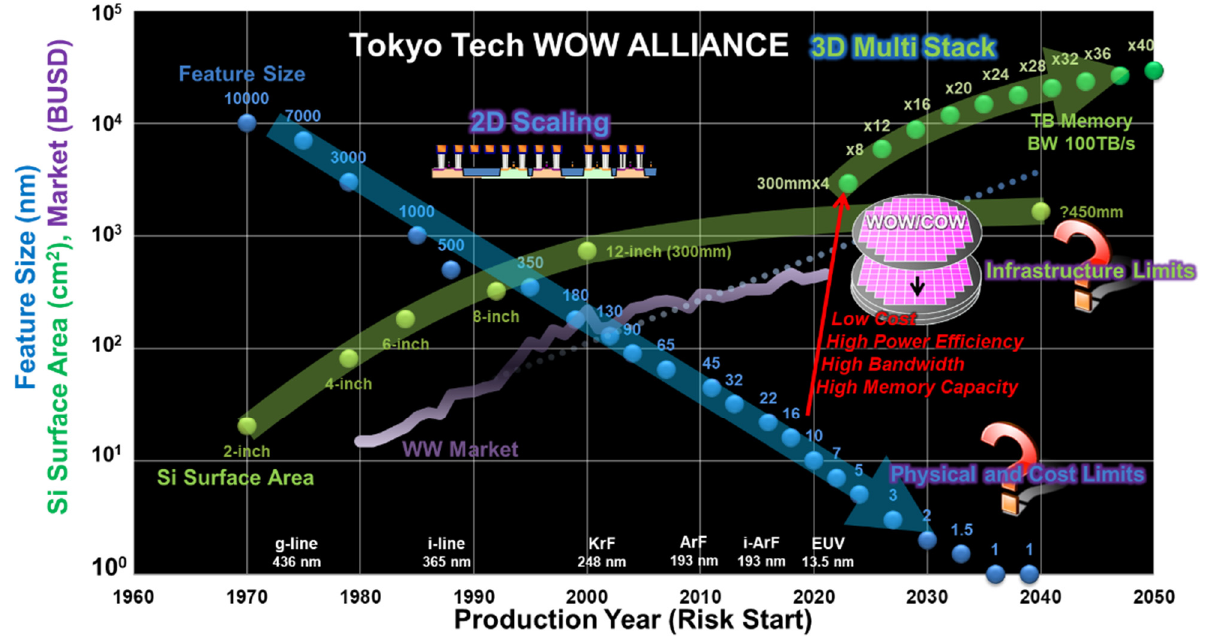
Figure 25. Historical trends and prospect of feature size of transistors, Si wafer area, and semiconductor market. See for example; Available online: http://www.wow.pi.titech.ac.jp/index.html (accessed on 25 December 2021).